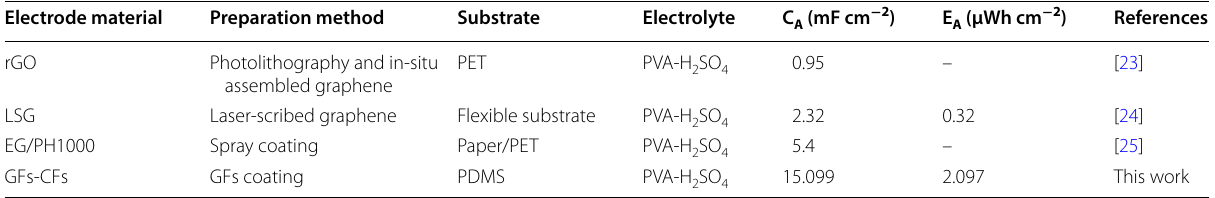
Table 1 Comparison of the capacitance, energy density of our supercapacitor with other works Electrode material Preparation